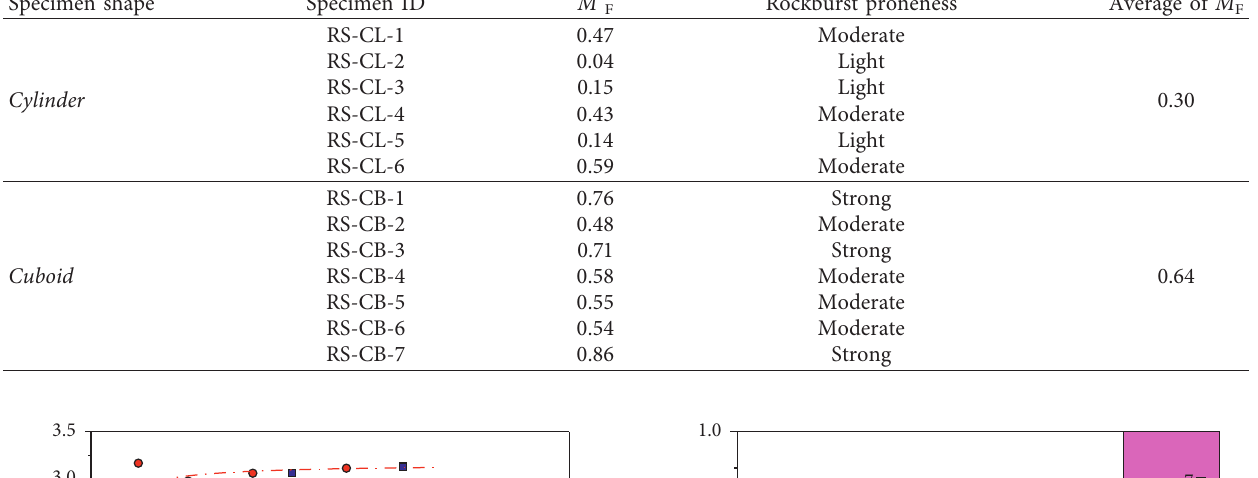
Table 8: Calculations of the far-field ejection mass ratio of specimens. Specimen shape